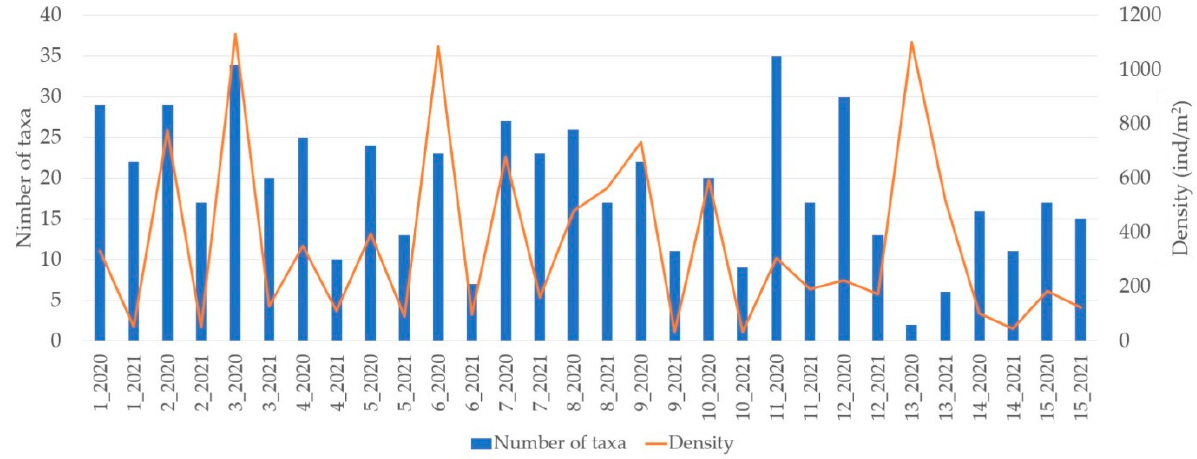
Figure 3. Dynamics of the values of the nutrients at the studied sites in 2020 and 2021.